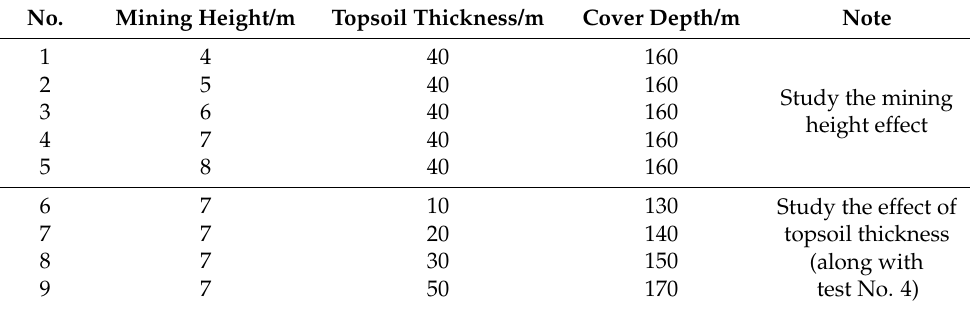
Table 4. Numerical modelling plan.